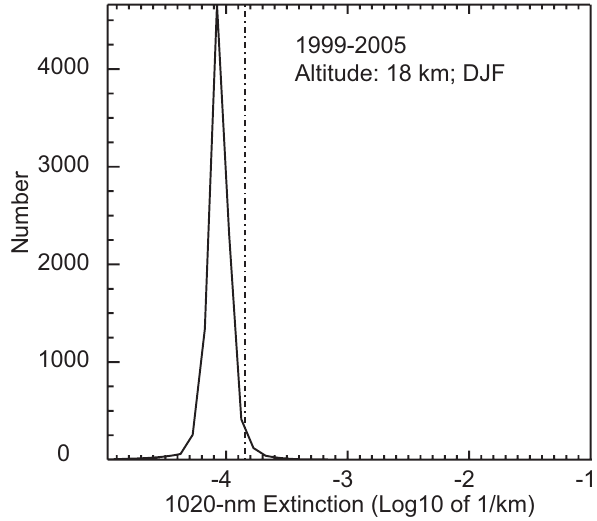
Fig. 5. The density of SAGE II aerosol extinction coefficient mea- surements at 18km in DJF for 1999–2005 for 525 to 1020nm aerosol extinction coefficient ratio greater than 2. The dash-dot line is the location of the separation of primary aerosol from enhanced aerosol and cloud/aerosol mixtures.